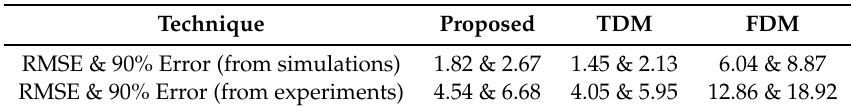
Table 2. Absolute location errors (from simulations and experiments) of receiver obtained for the proposed, TDM and FDM techniques in terms of 90% Error and RMSE